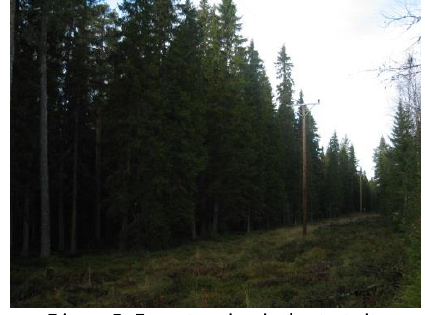
Figure 5: Forest region in the test